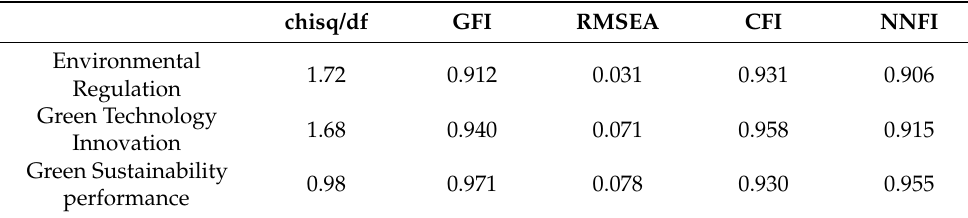
Table 3. Results of model fitting.